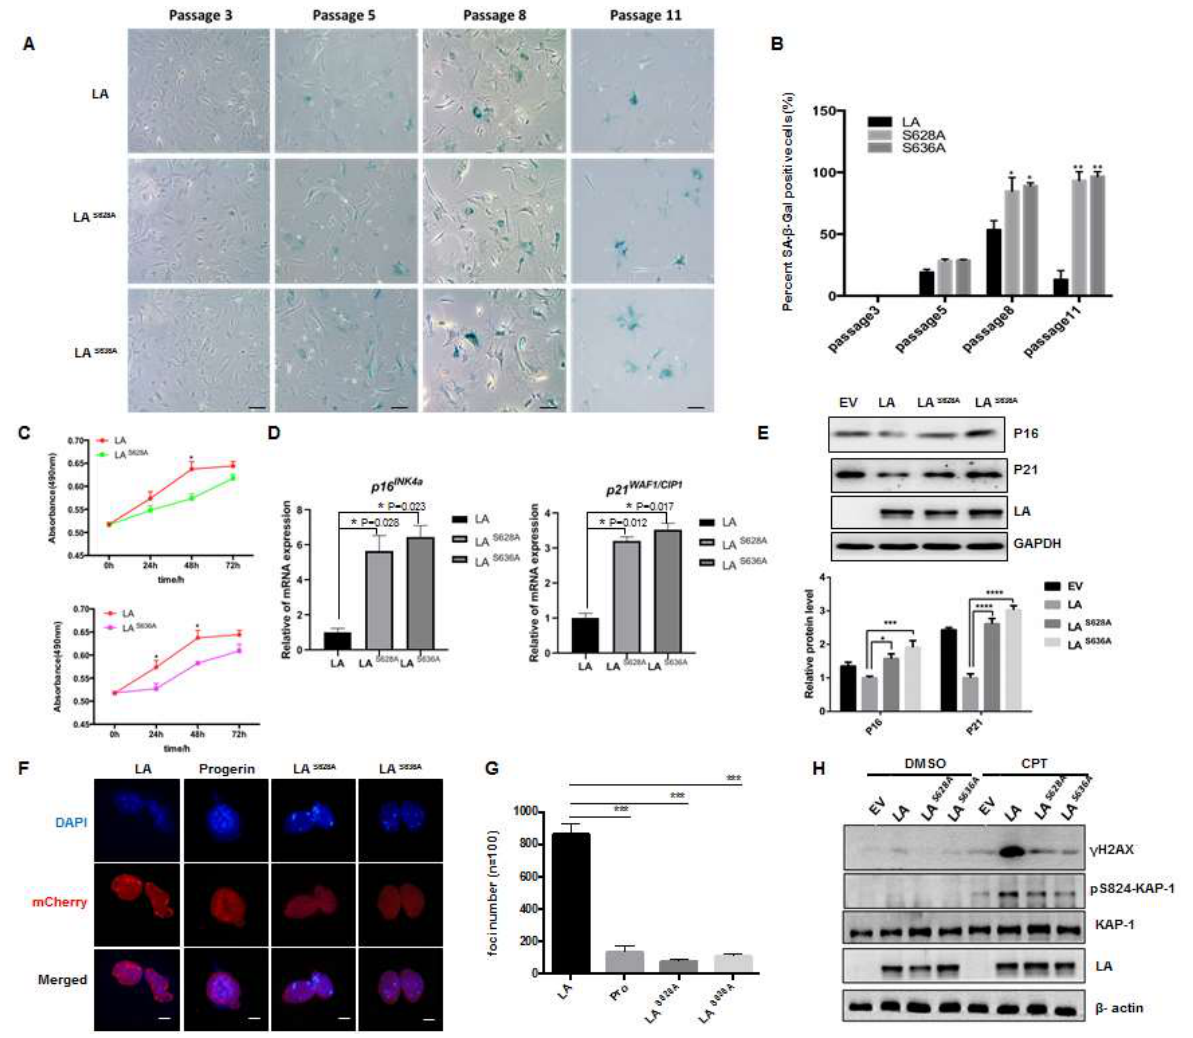
Figure 6. Role of lamin A phosphorylation at Ser628 and Ser636 in cellular senescence. ( A ) Repre- sentative images of SA- β -gal activity showing blue-stained senescent cells in Ser628/Ser636-mutant lamin A-expressing MEFs and wild type controls (scale bar, 100 µ M). ( B ) Quantification of SA- β - Gal-positive staining ( A ) from six views randomly captured for each group. Data represent means ± SEM. * p < 0.05, ** p < 0.01. ( C ) Graph showing differences in the proliferative ability of MEF cells expressing mutant and wild type lamin A, determined by MTS assay. ( D ) Quantitative RT-PCR analysis of mRNA levels of the indicated p16 INK4a and p21 WAF1/CIP1 genes in cells expressing mutant and wild type lamin A MEFs. Data represent means ± SEM. * p < 0.05. ( E ) Western blot assay showing the levels of senescence marker proteins in cells expressing mutant and wild type lamin A. EV is empty vector plvx-mCherry-C1. Quantification of P16 and P21 protein expression are shown below. were repeated three times with consistent results. *** p < 0.001, **** p < 0.0001. ( F ) Representative immunofluorescence confocal microscopy images of MEF cells expressing Ser628/Ser636-mutant